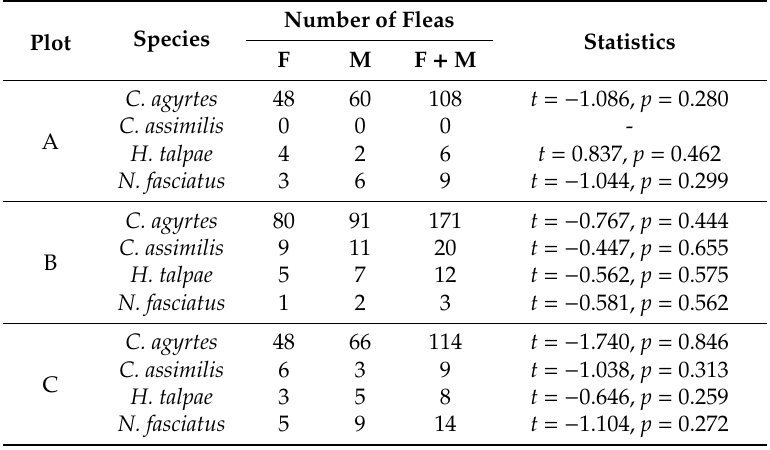
Table 1. Occurrence and number of fleas in the experimental plots (F—females, M—males).